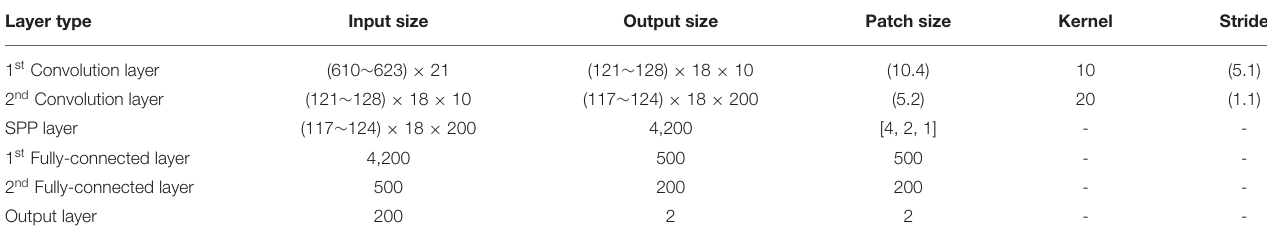
TABLE 2 | Architecture and parameter settings of SPP-net.